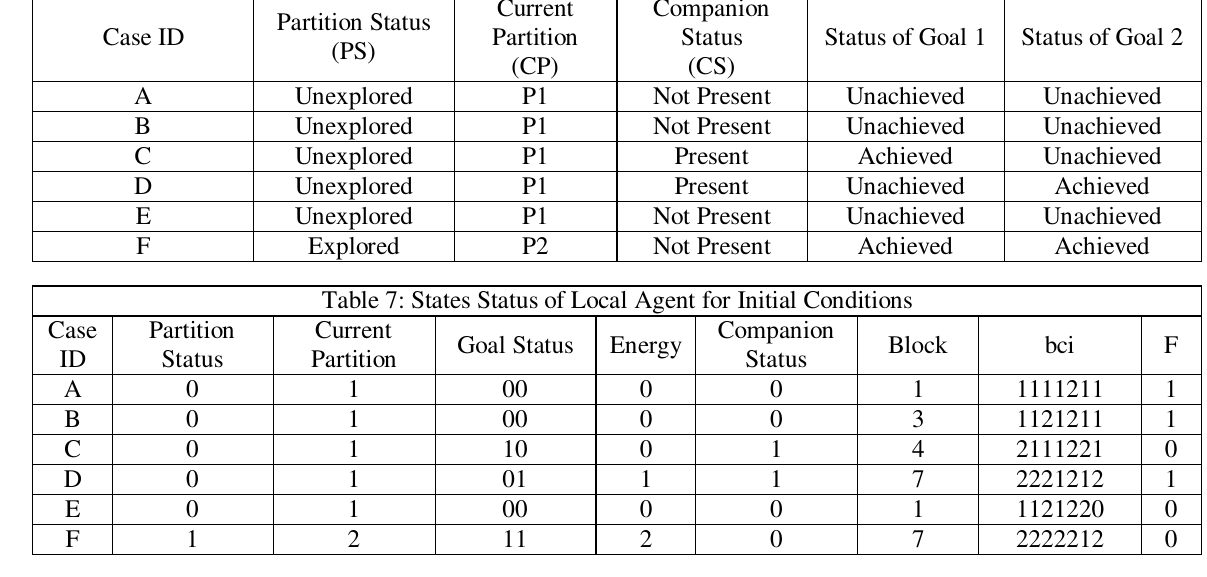
Table 6: Initial Status for Local Agent